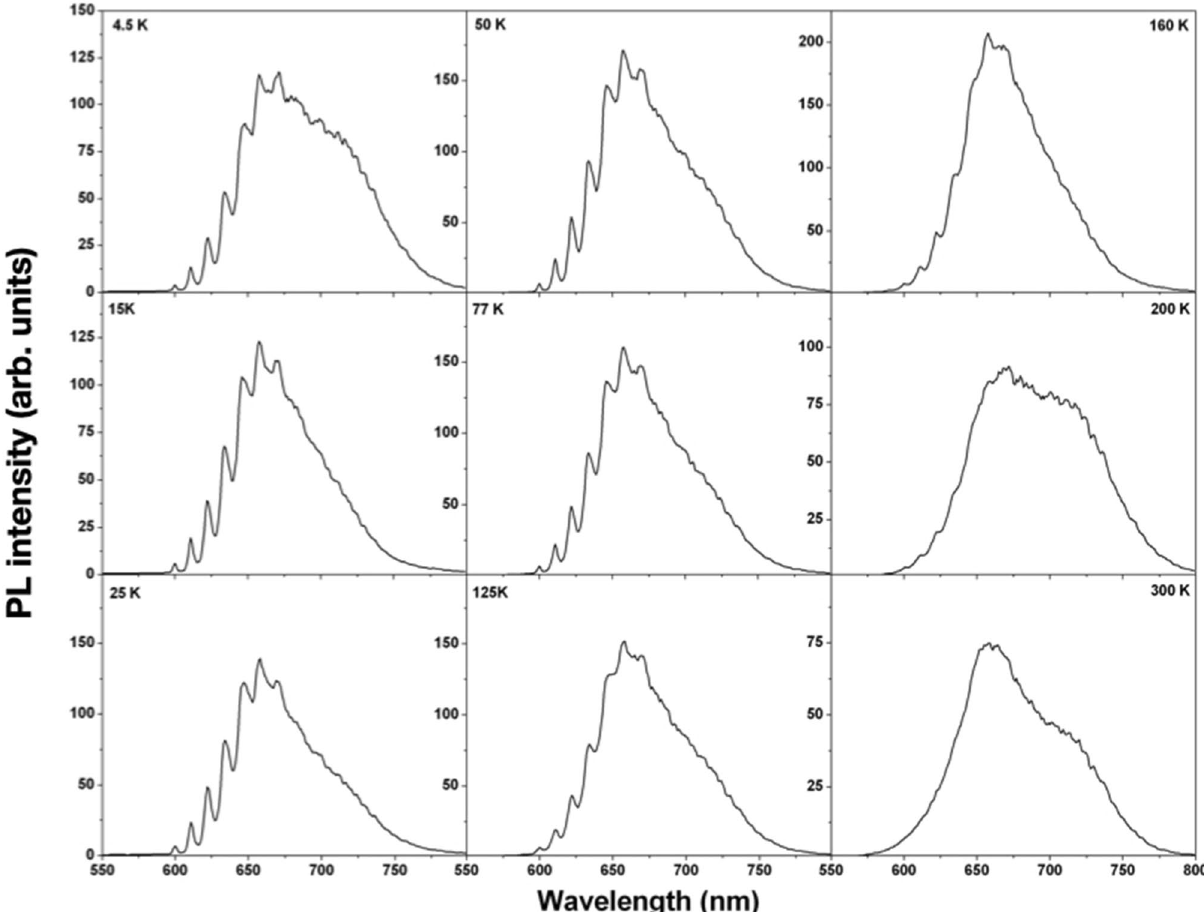
488 nm excitation as a function of